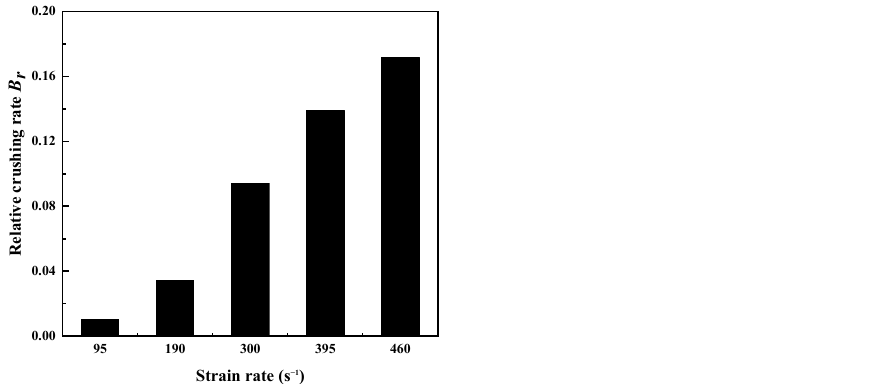
Figure 15 indicates the influence of moisture content on